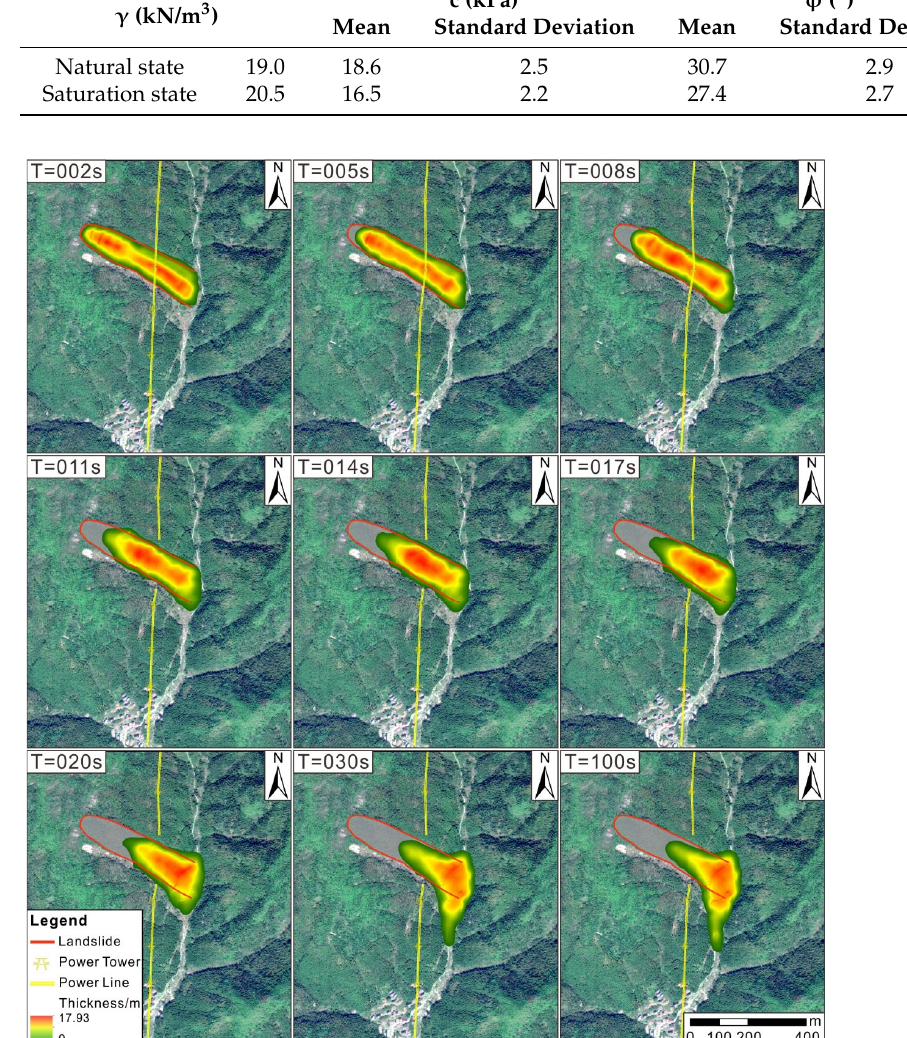
Figure 13. Shangfang landslide movement process.